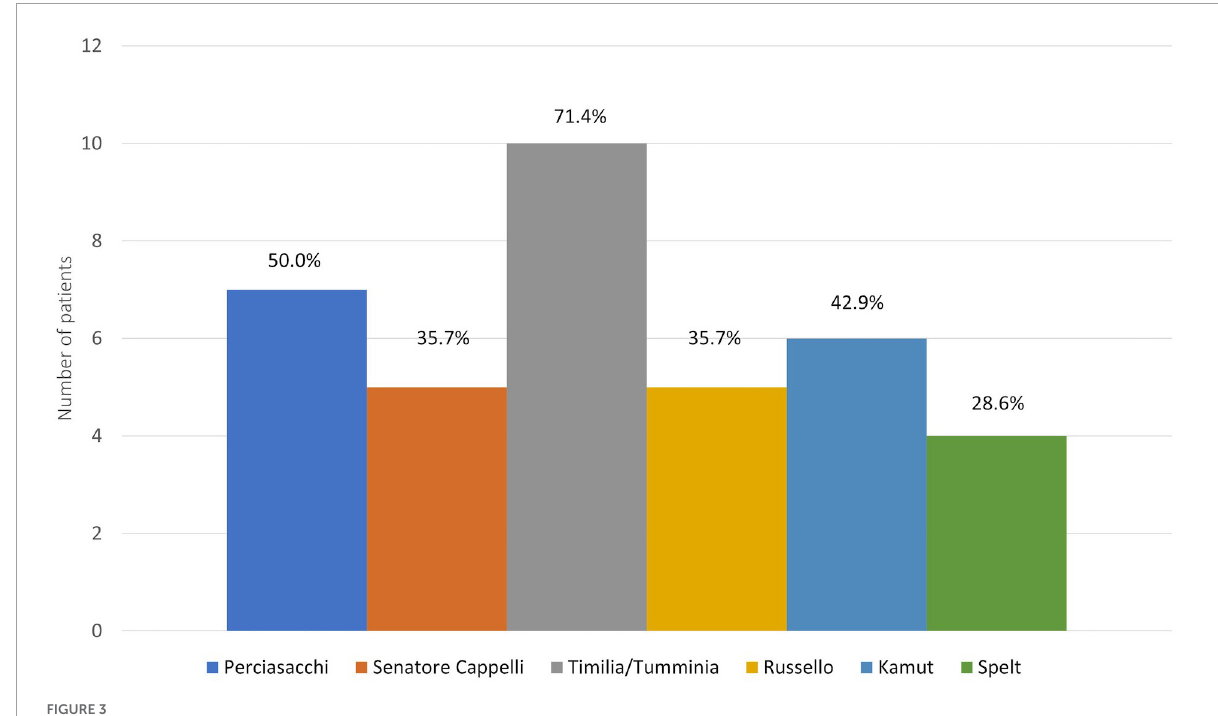
FIGURE3 Kind of ancient grains consumed by patients with strict adherence to the modern wheat-free